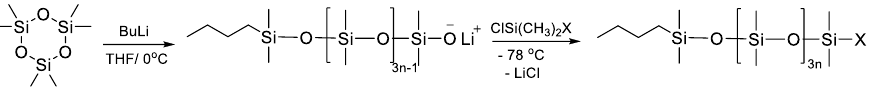
Figure 10. Scheme for the preparation of polydimethylsiloxane monochelics by the AROP mecha- nism.